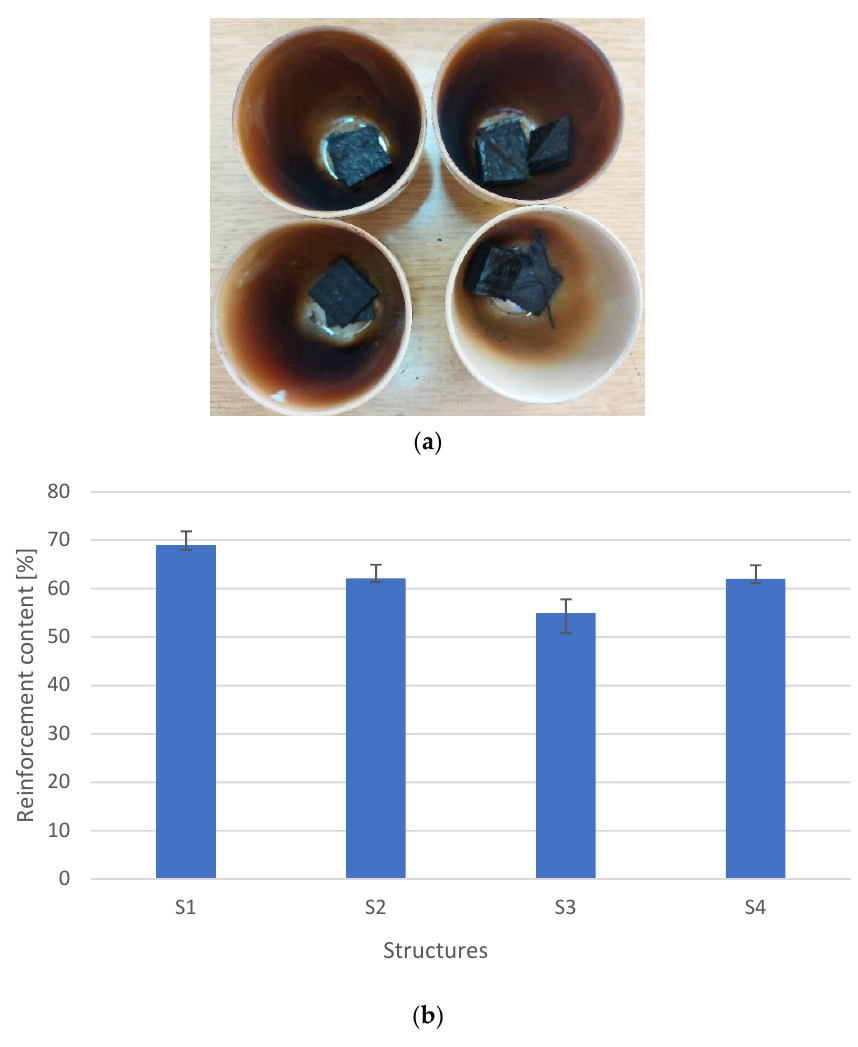
Figure 4. Reinforcement content ( a ) view after pyrolysis, ( b ) graph on the dependence of different structures.